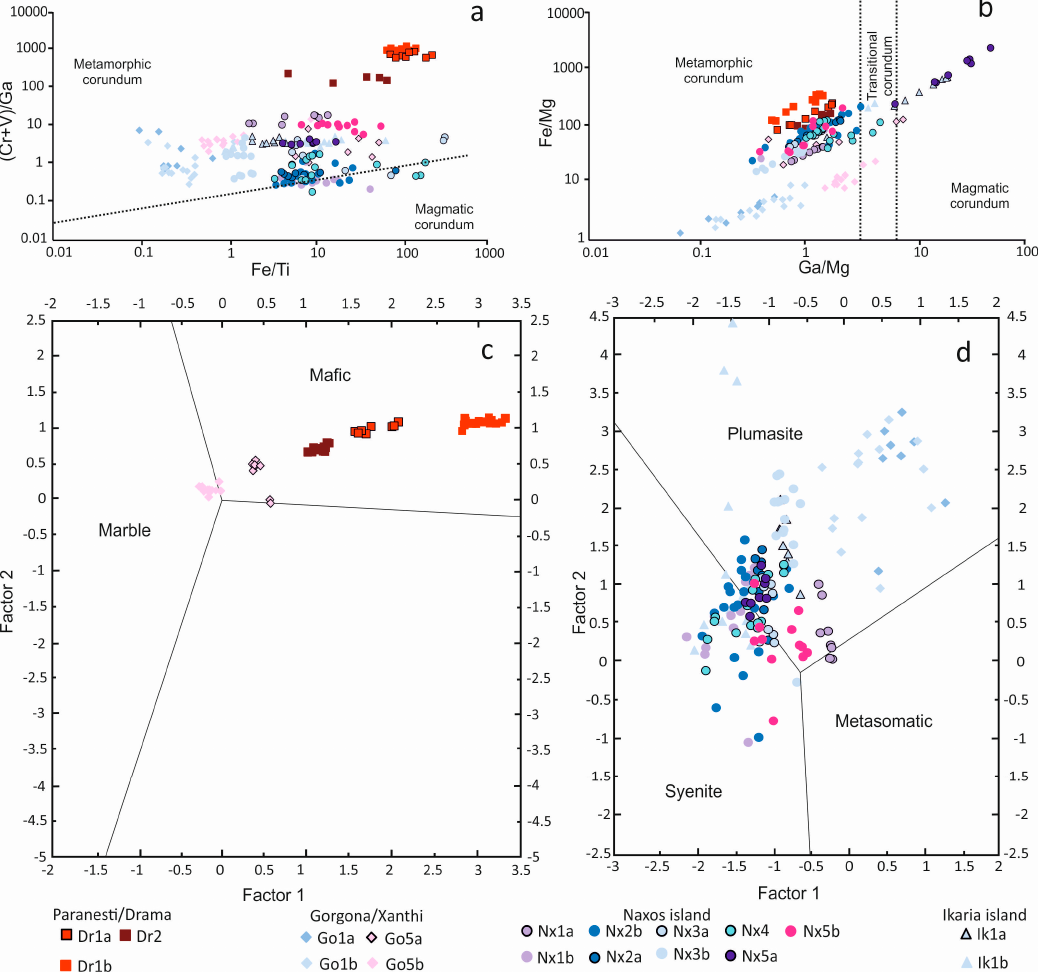
Figure 4. Greek corundum LA-ICP-MS analyses plotted on ( a ) (Cr+V)/Ga versus Fe/Ti discrimination diagram separating the fields for magmatic and metamorphic corundums (adapted from Sutherland et al. [40] and Harris et al. [41]; ( b ) Fe/Mg versus Ga/Mg discrimination separating the fields for magmatic, transitional and metamorphic corundums (adapted from Peucat et al. [42], Sutherland et al. [40] (both a and b are from Voudouris et al. [18]); ( c ) plot of Greek rubies (and Xanthi pink sapphires) within mafic rocks and marble field in discriminant factors diagram adapted after Giuliani et al. [43]; ( d ) plot of Greek sapphires within plumasite and syenite field in discriminant factors diagram adapted after Giuliani et al.